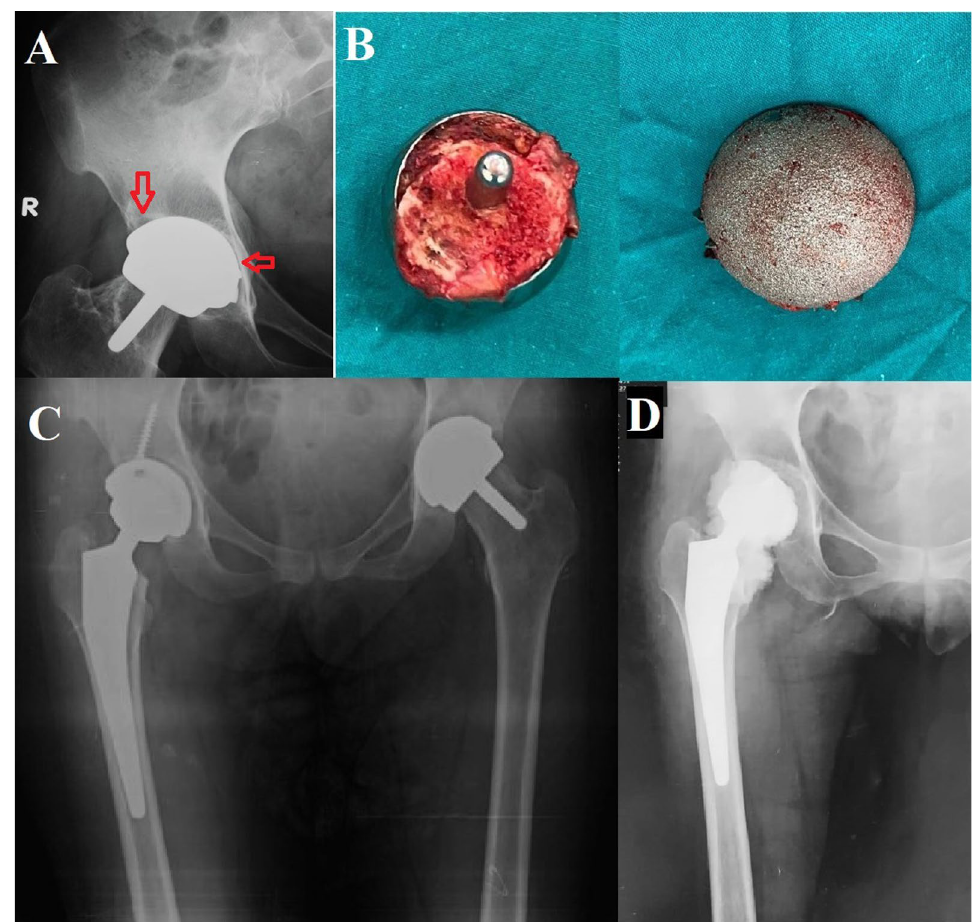
Fig. 2 Revision surgeries performed for the patient. A Right hip plain radiograph showing radiolucent lines around the acetabular component (red arrows). B An image of the hip resurfacing implants after being removed during the first revision surgery shows the acetabular component’s clear back surface. C Cementless THA implanted at the first revision surgery. D After diagnosing PJI, the first-stage THA cement spacer was performed with the stem left in place, and a cement ball was inserted in the